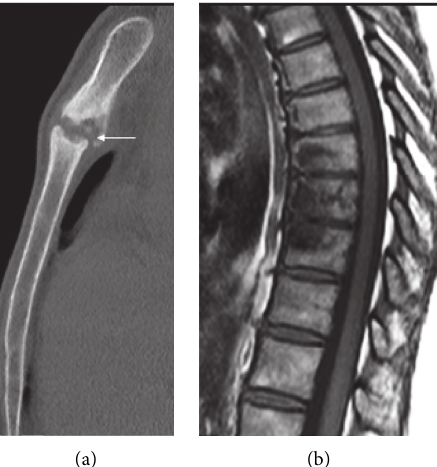
Figure 16: A 27-year-old female with SAPHO. There is hyperostosis and osteitis of the sternomanubrial junction on the sagittal CT (a). Contiguous involvement of multiple vertebral bodies anteriorly with sparing of the intervening disc space as demonstrated on sagittal T1 thoracic spine is typical of this condition